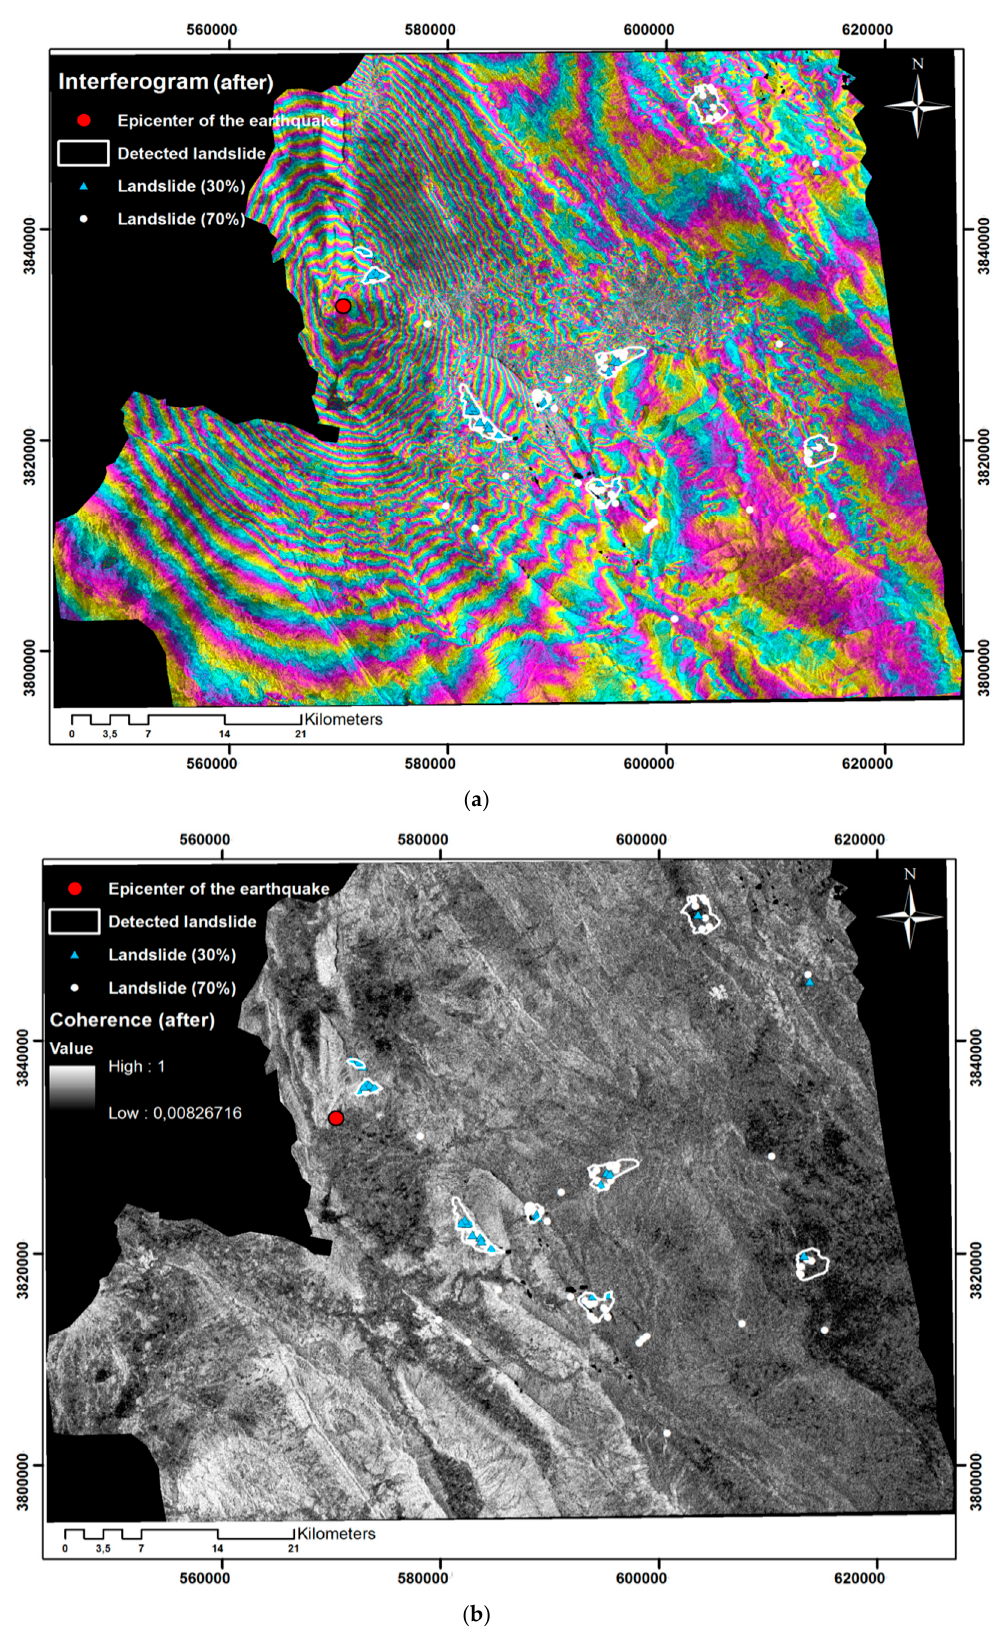
Figure 11. The interferogram and decorrelation errors ( a ) and coherence ( b ) after the earthquake.